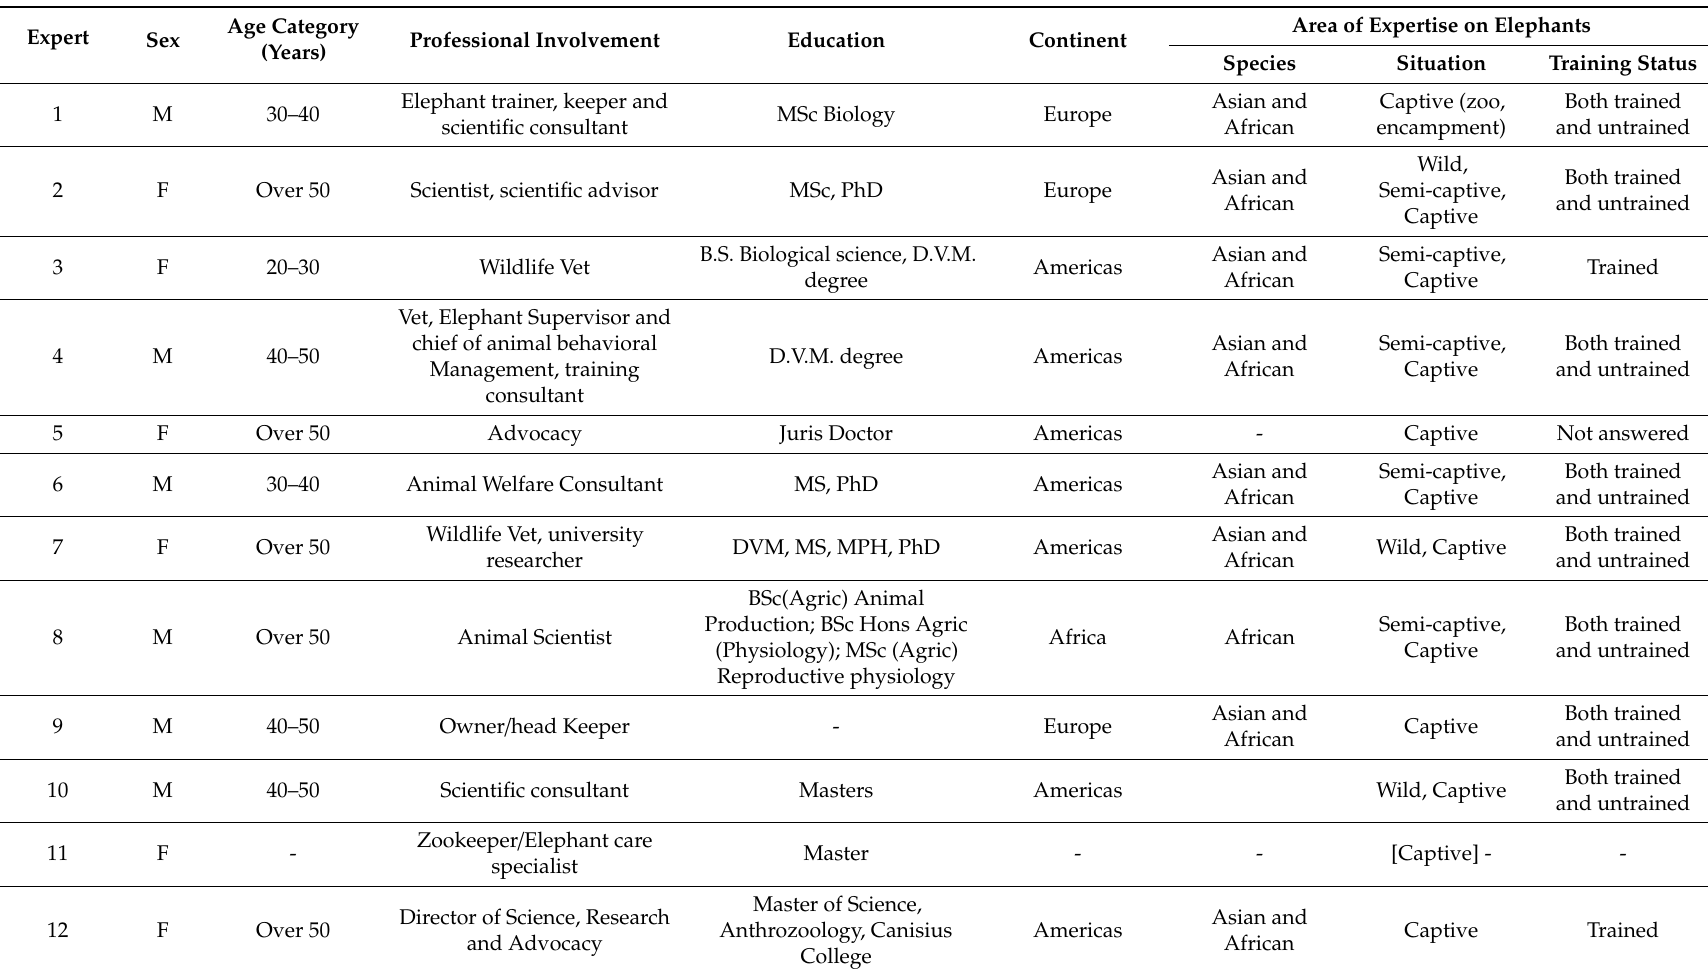
Table A3. Experts’ demographic